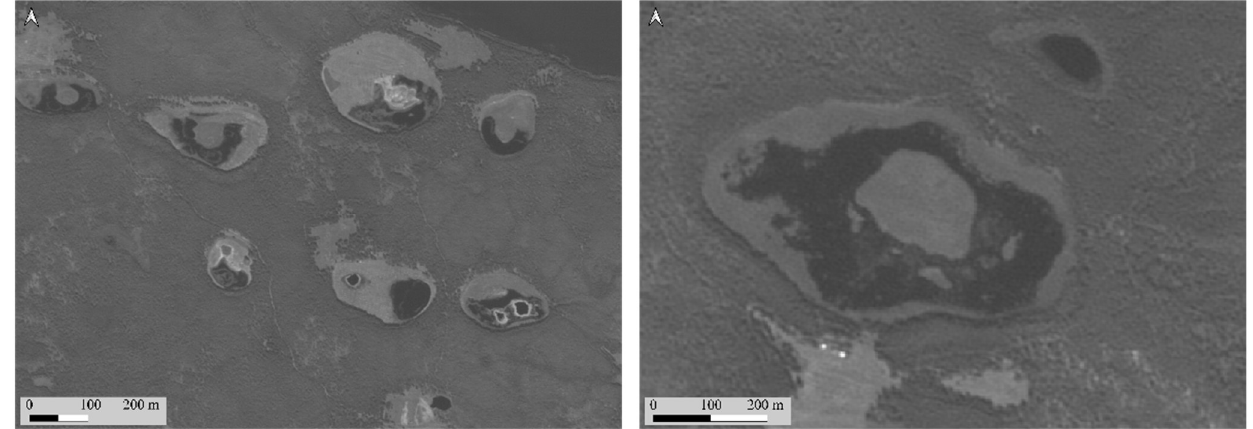
Figure 4. Image showing half-moon shaped unconnected alas lakes ( left ) and a circular unconnected alas lake ( right ).